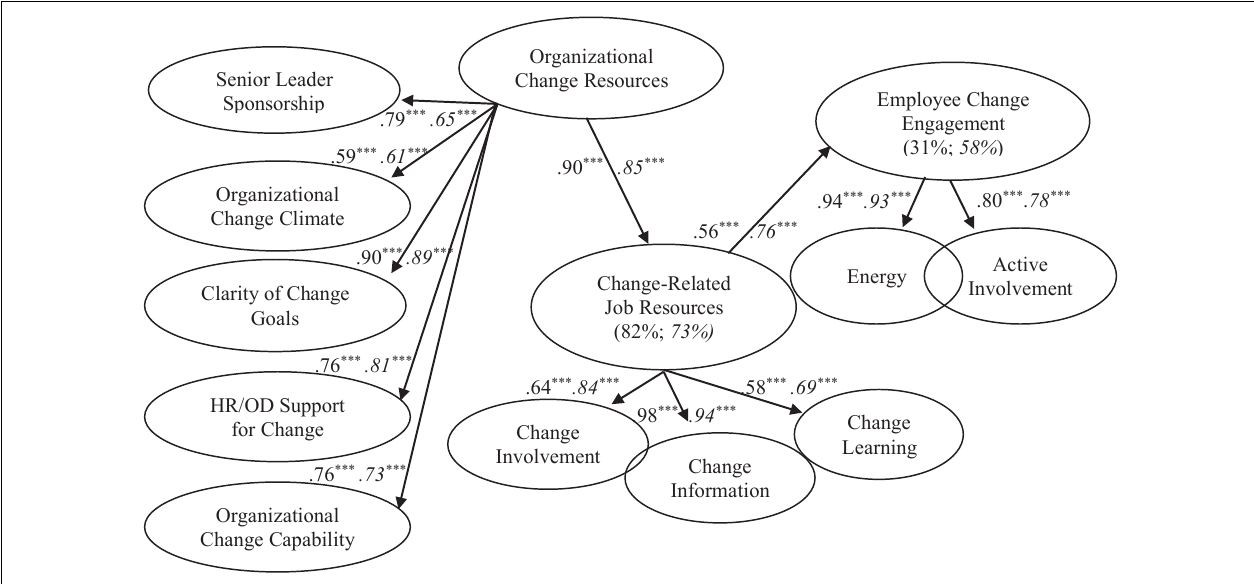
FIGURE 2 | Respecified model; standardized parameter estimates; percent variance explained (Sample 2 in italics). Items, errors, and indirect effects not shown for ease of representation. *** p <